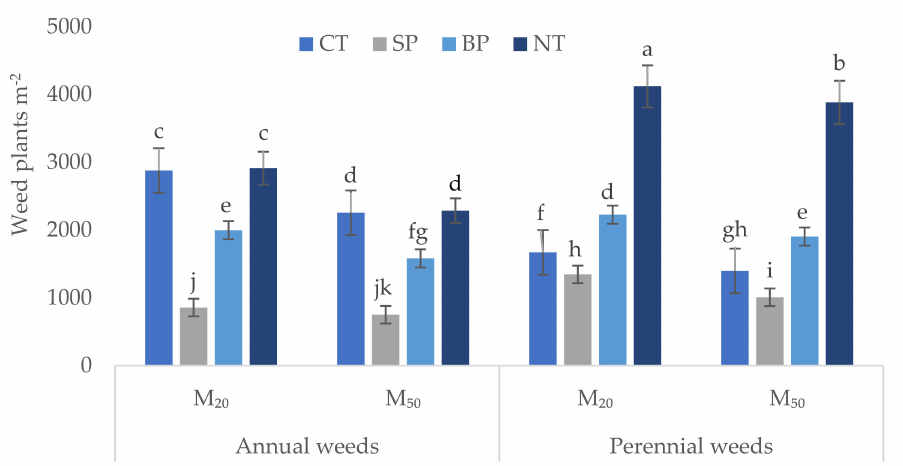
Figure 3. Density of emerged annual and perennial weeds from topsoil (0–15 cm) at 30 days after emergence collected from Beluapara after 3 years under strip planting (SP), bed planting (BP), no tillage (NT) and conventional tillage (CT). Values are means of four replicates. The means with similar letters (a − k) do not differ significantly at p ≤ 0.05. M 20 = 20% residue, M 50 = 50% residue. Whiskers mean the standard